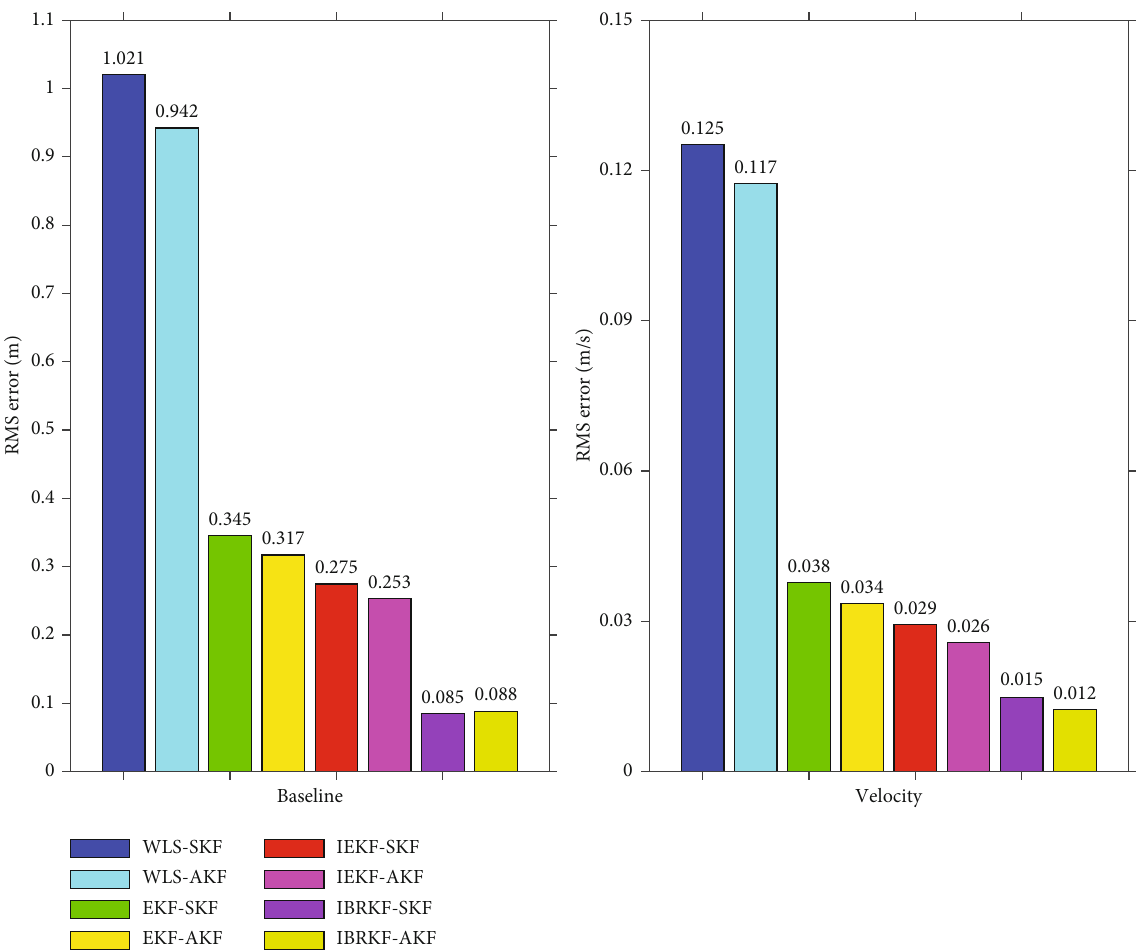
Figure 18: The RMS errors of baseline and velocity of various algorithms (Data